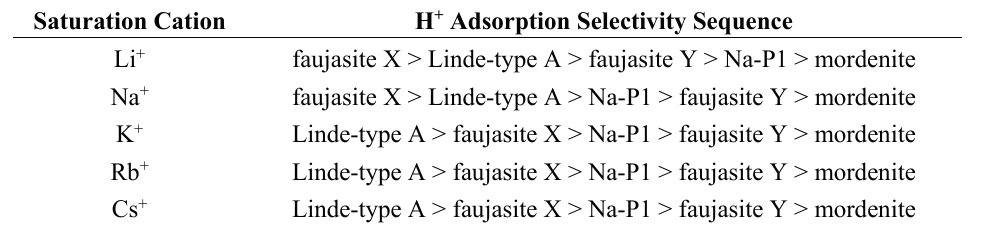
Table 2. Proton adsorption selectivity sequences of zeolites: the effect of zeolite species.